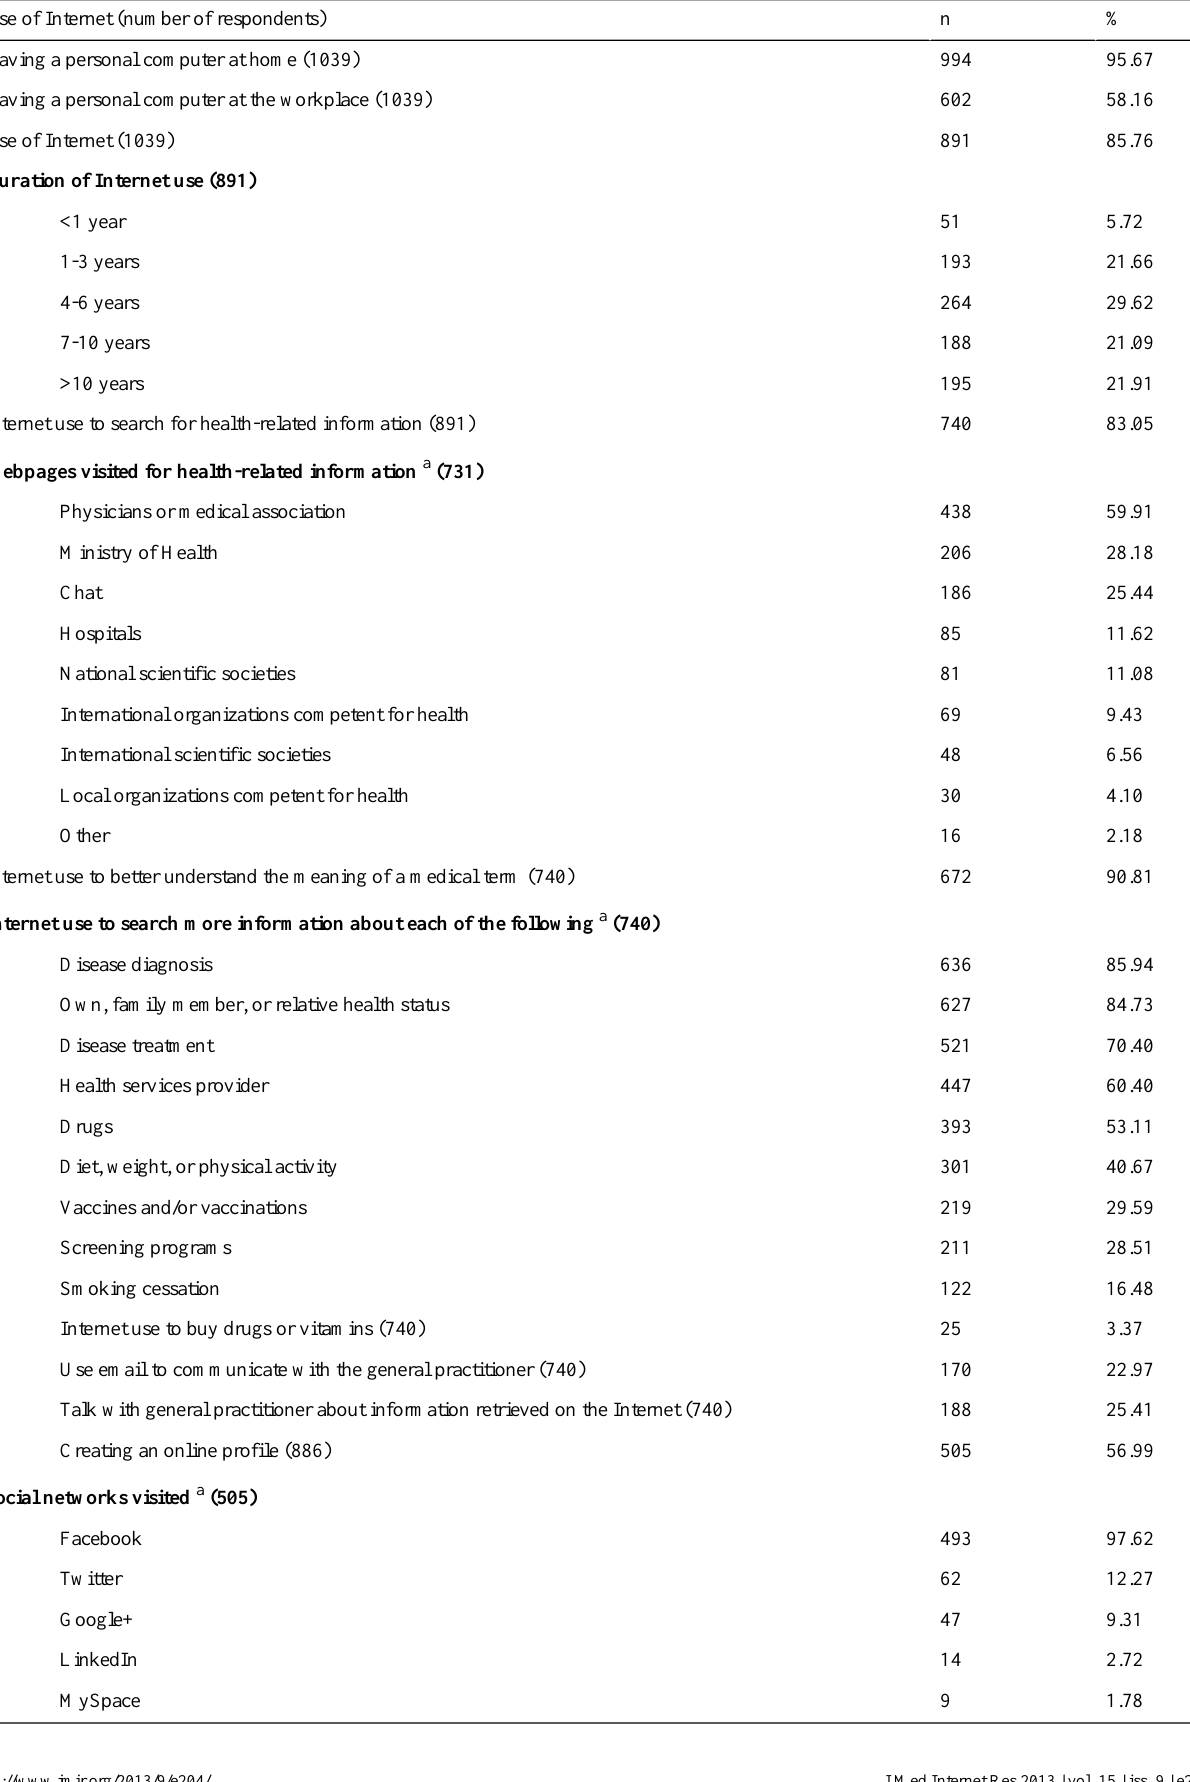
Table 2. Personal computer and Internet use patterns of